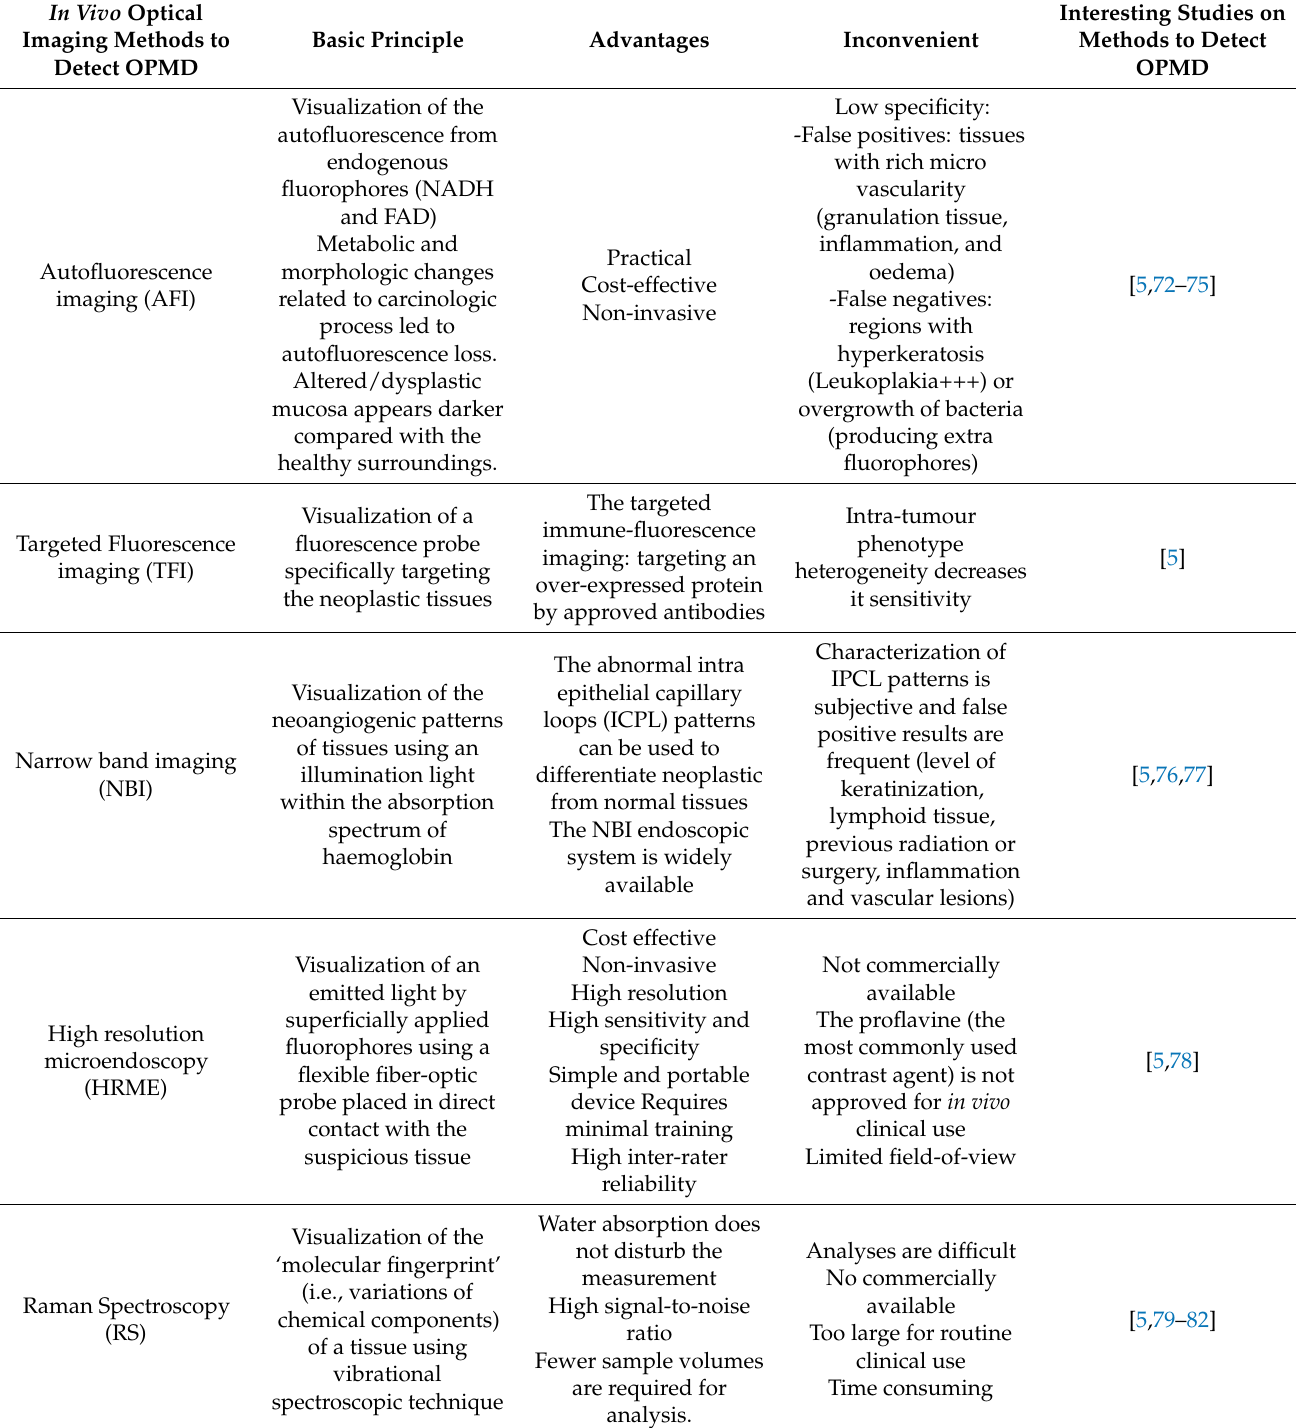
Table 1. Main in vivo optical imaging methods that could be used as an adjunct to conventional oral examination in oral premalignant disorders screening are autofluorescence imaging (AFI), targeted fluorescence imaging (TFI), high-resolution microendoscopy (HRME), narrow band imaging (NBI), Raman spectroscopy (RS). For each method, basic principles, advantages and inconvenient are described as well as